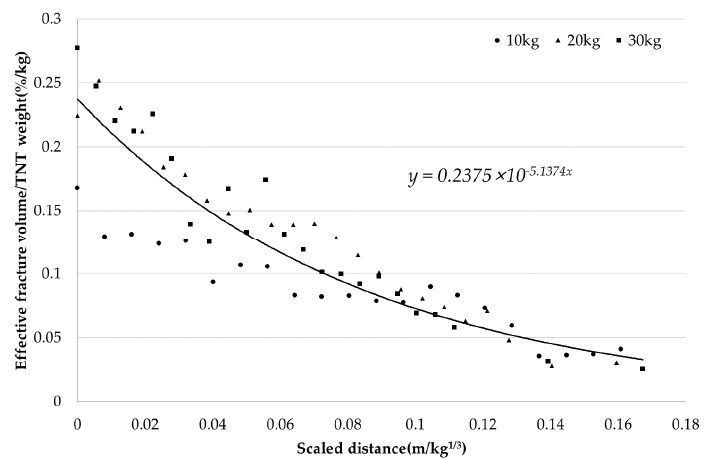
Figure 8. E ff ective fracture volume per unit weight of TNT according to scaled distance. Figure 8. Effective fracture volume per unit weight of TNT according to scaled distance.